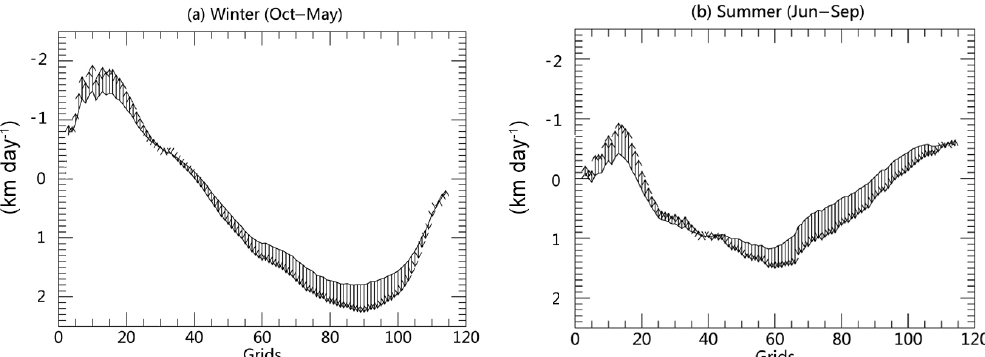
Figure 8. Cross-gate SIM climatology (black solid line) and trends (arrows) for (a) winter and (b) summer over the 38-year period. The left end represents for the North American side and the right the Eurasian